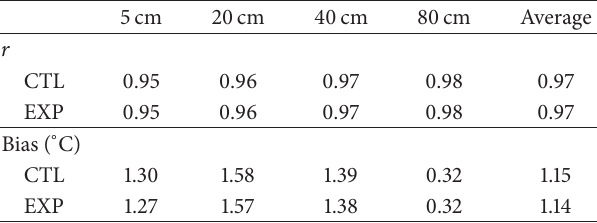
Table 4: Same as Table 3 but at GS site.